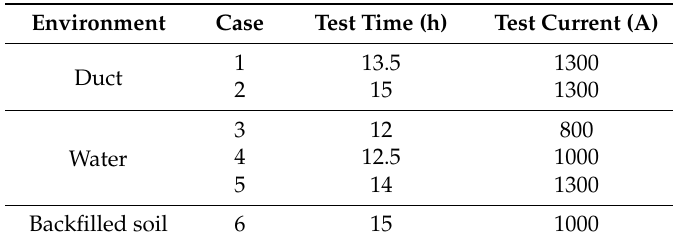
Table 3. Current heating experiment scheme.